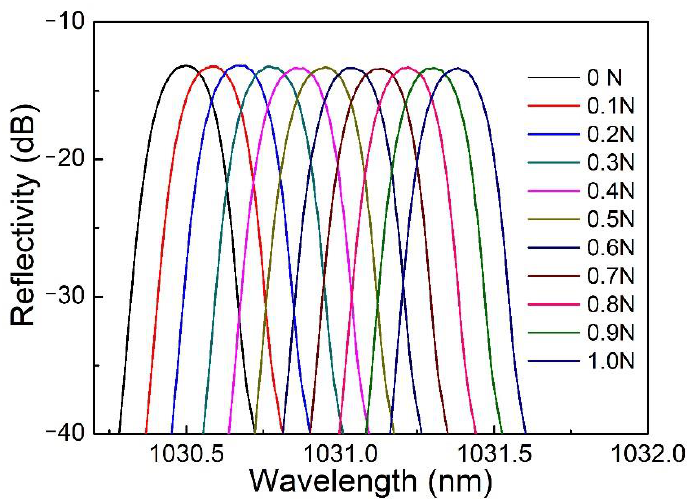
Figure 7. The reflection spectrum of an apodized FBG with a core diameter of 4.4 μm varies with strain.